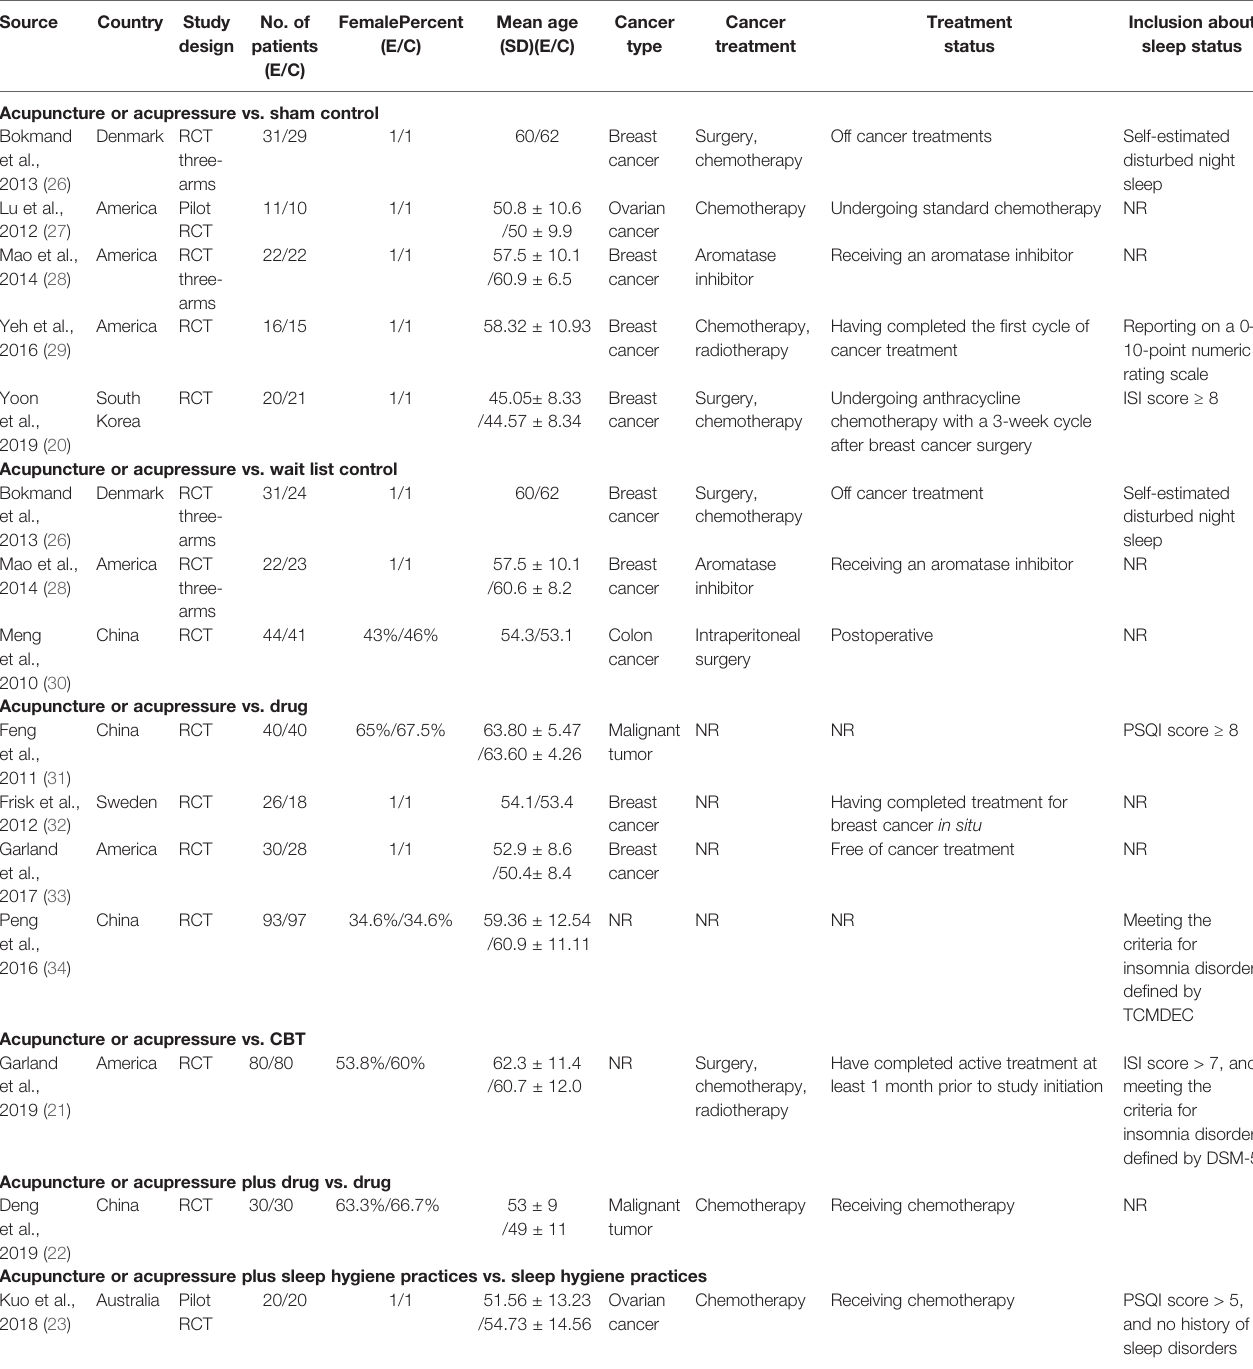
TABLE 2 | Characteristics of studies and patients.